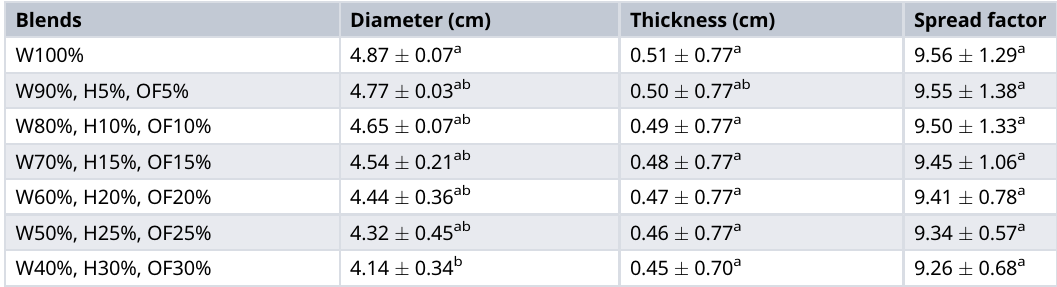
Table 5. Effect of blending ratios on physical characteristics of